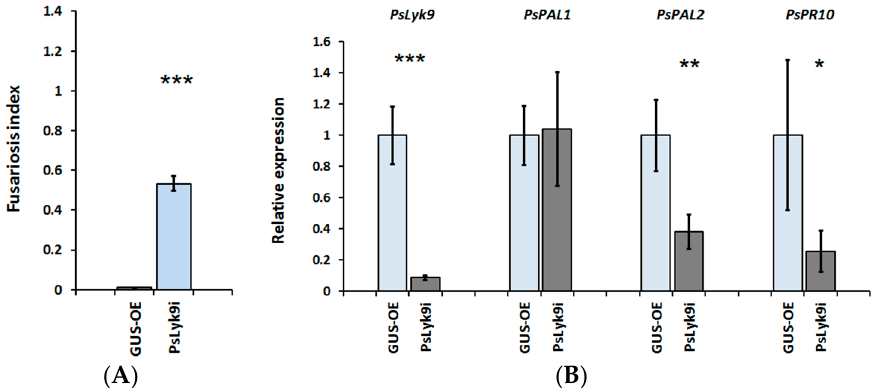
Figure 5. Effect of PsLyk9 RNAi on the resistance of pea plants to the weakly pathogenic fungus F. culmorum 891 and the transcript levels of defense-response genes. ( A ) Disease level in PsLyk9 -RNAi and GUS-OE transgenic pea plants; ( B ) The expression levels of the PsPAL1 and PsPAL2 , PsPR10 defense-response genes in transgenic pea roots with PsLyk9 knockdown; GUS-OE—transgenic pea plants transformed with pB7WG2D-GFP construct (control); PsLyk9 -RNAi—transgenic pea plants transformed with the pK7GWIWG2D- PsLyk9i construct. Error bars indicate the SEM of seven-ten biological repeats. Asterisks indicate statistically significant differences compared with control water-treated roots: *** p < 0.001, ** p < 0.01, * p < 0.05.